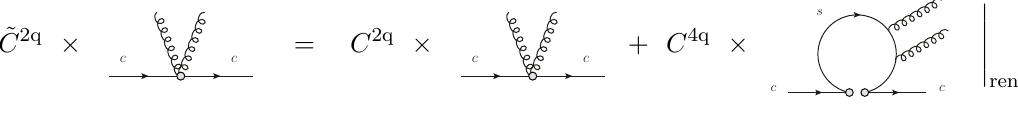
Figure 4 . Second matching of two-quark operators in the OPE of case II (see section